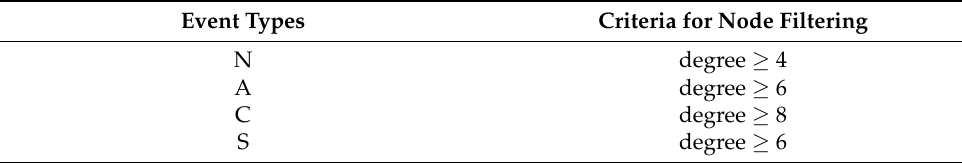
Table 2. Event types and the criteria for node